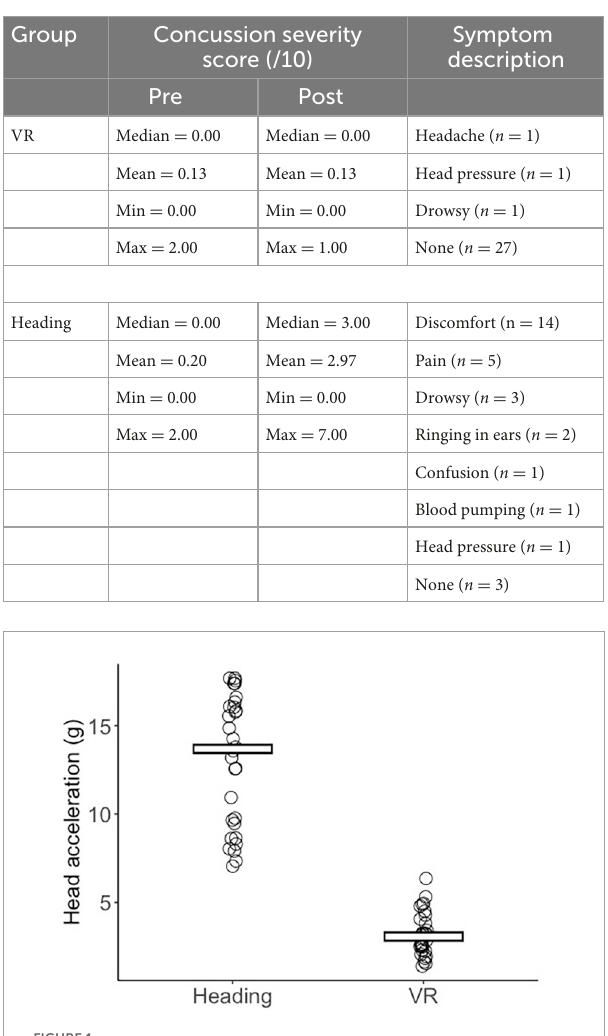
FIGURE1 Jitter plot displaying each participant’s mean peak head acceleration ( g ) across the Heading and VR conditions. Crossbars reflect the group median.